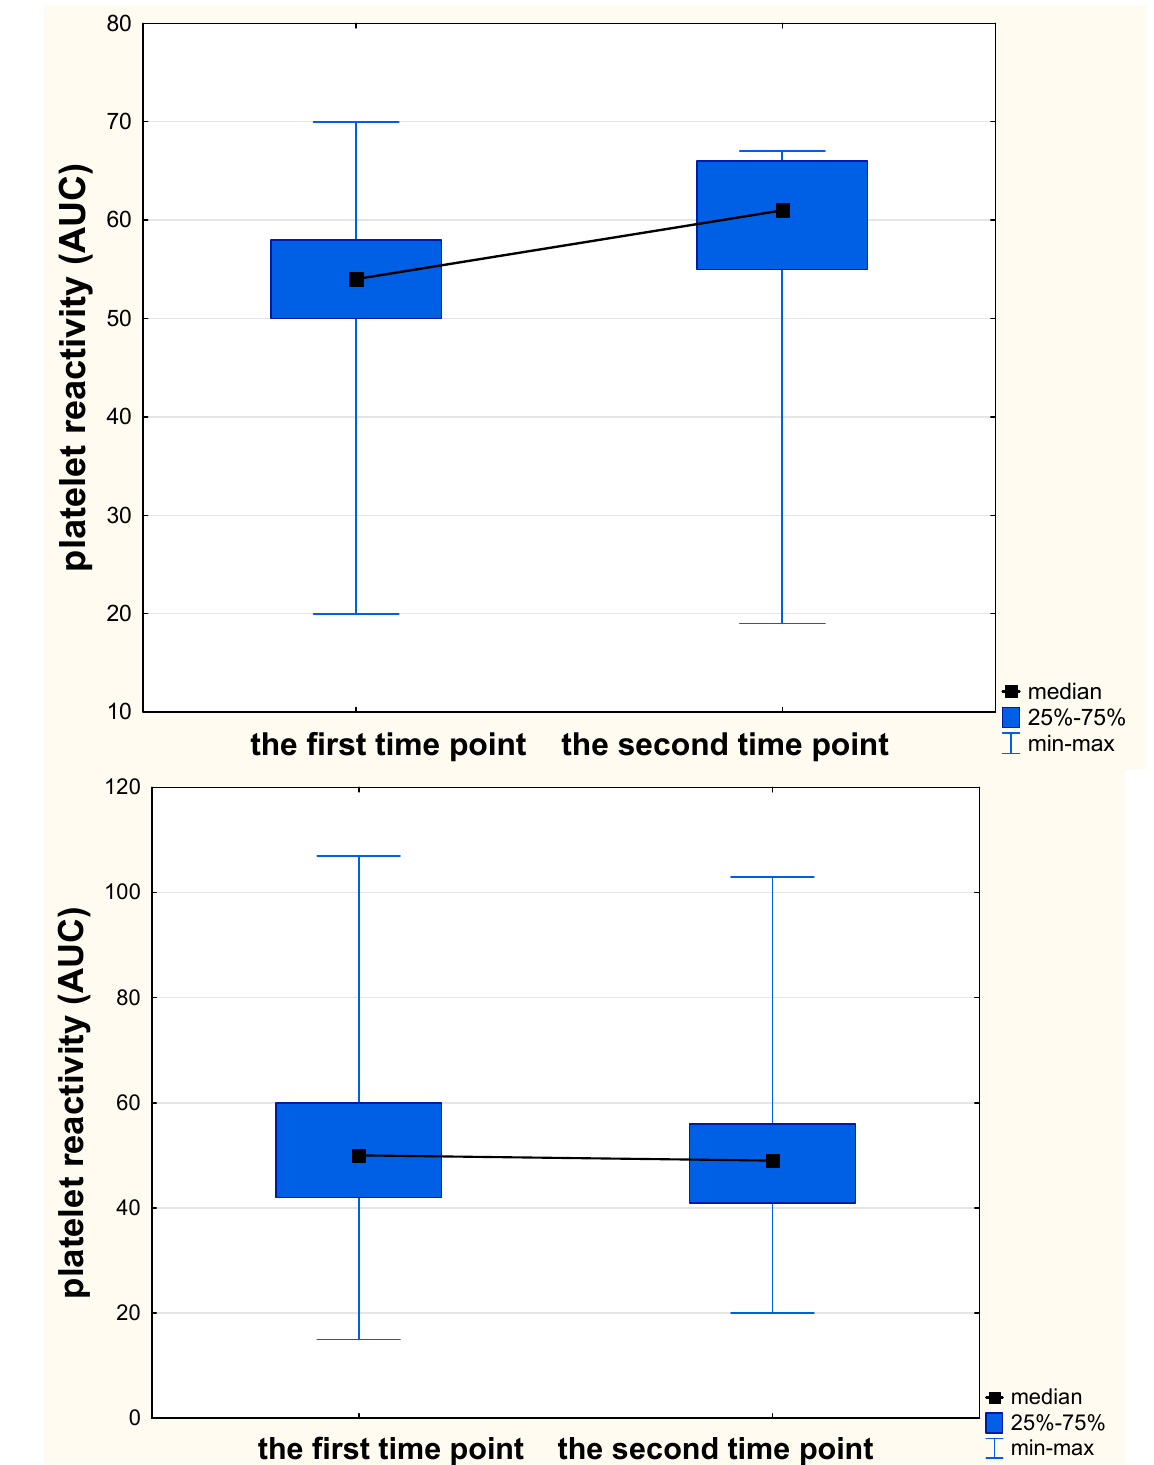
Figure 5. Dynamics of changes in platelet reactivity over time in relation to the size of acute ischemic infarct. Significant and favorable changes of platelet reactivity (expressed in area under the curve units—AUC) in stroke subjects with insignificant (<2 cm 3 ) size of acute ischemic infarct in the diffusion-weighted sequence of magnetic resonance imaging ( A ). Insignificant and unfavorable changes of platelet reactivity in stroke subjects with large (>15 cm 3 ) ( B ), moderate (5–15 cm 3 ) ( C ) and small (2–5 cm 3 ) ( D ) size of acute ischemic infarct. Extremely unfavorable increase of platelet reactivity can be seen among subjects with a large and moderate size of acute ischemic infarct.